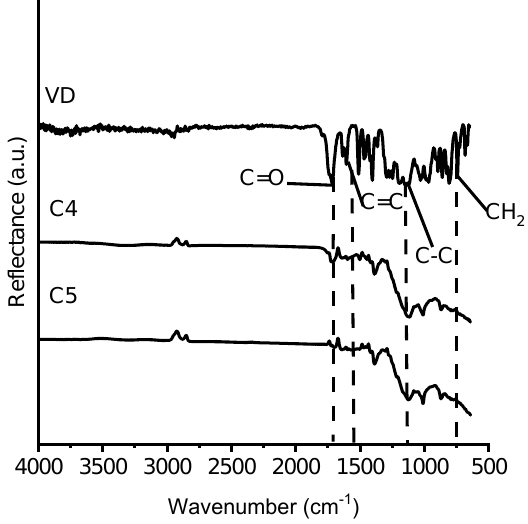
Figure 5. FT-IR spectra of VD and the cross-linked polymers C4 and C5.